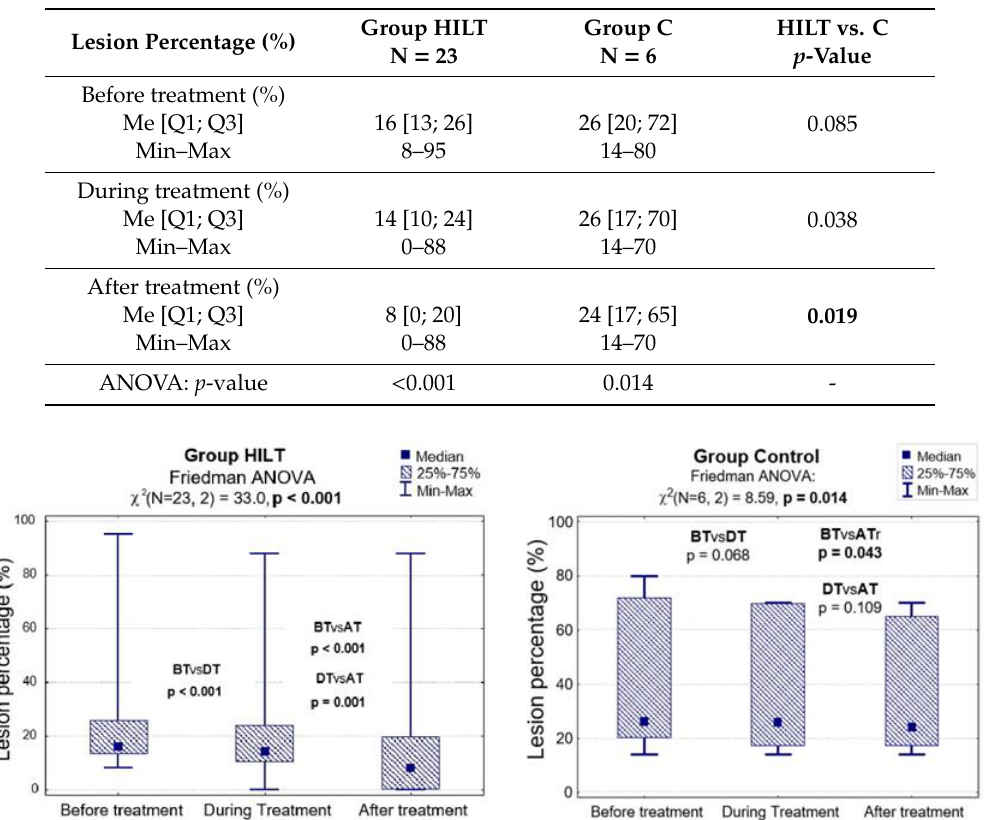
Figure 5. Lesion percentage before, during and after treatment in group HILT and group C, and the Friedman ANOVA results. BT, before treatment (day 0); DT, during treatment (day 13 – 15); AT, after treatment (day 38 – 40). Table 3. The effect of HILT on lesion percentage reduction (median and IQR) for horses from group HILT and group